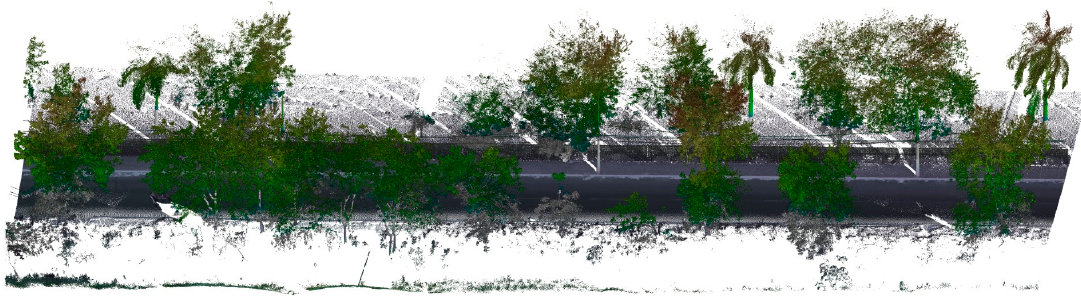
Figure 15. Test area point cloud.